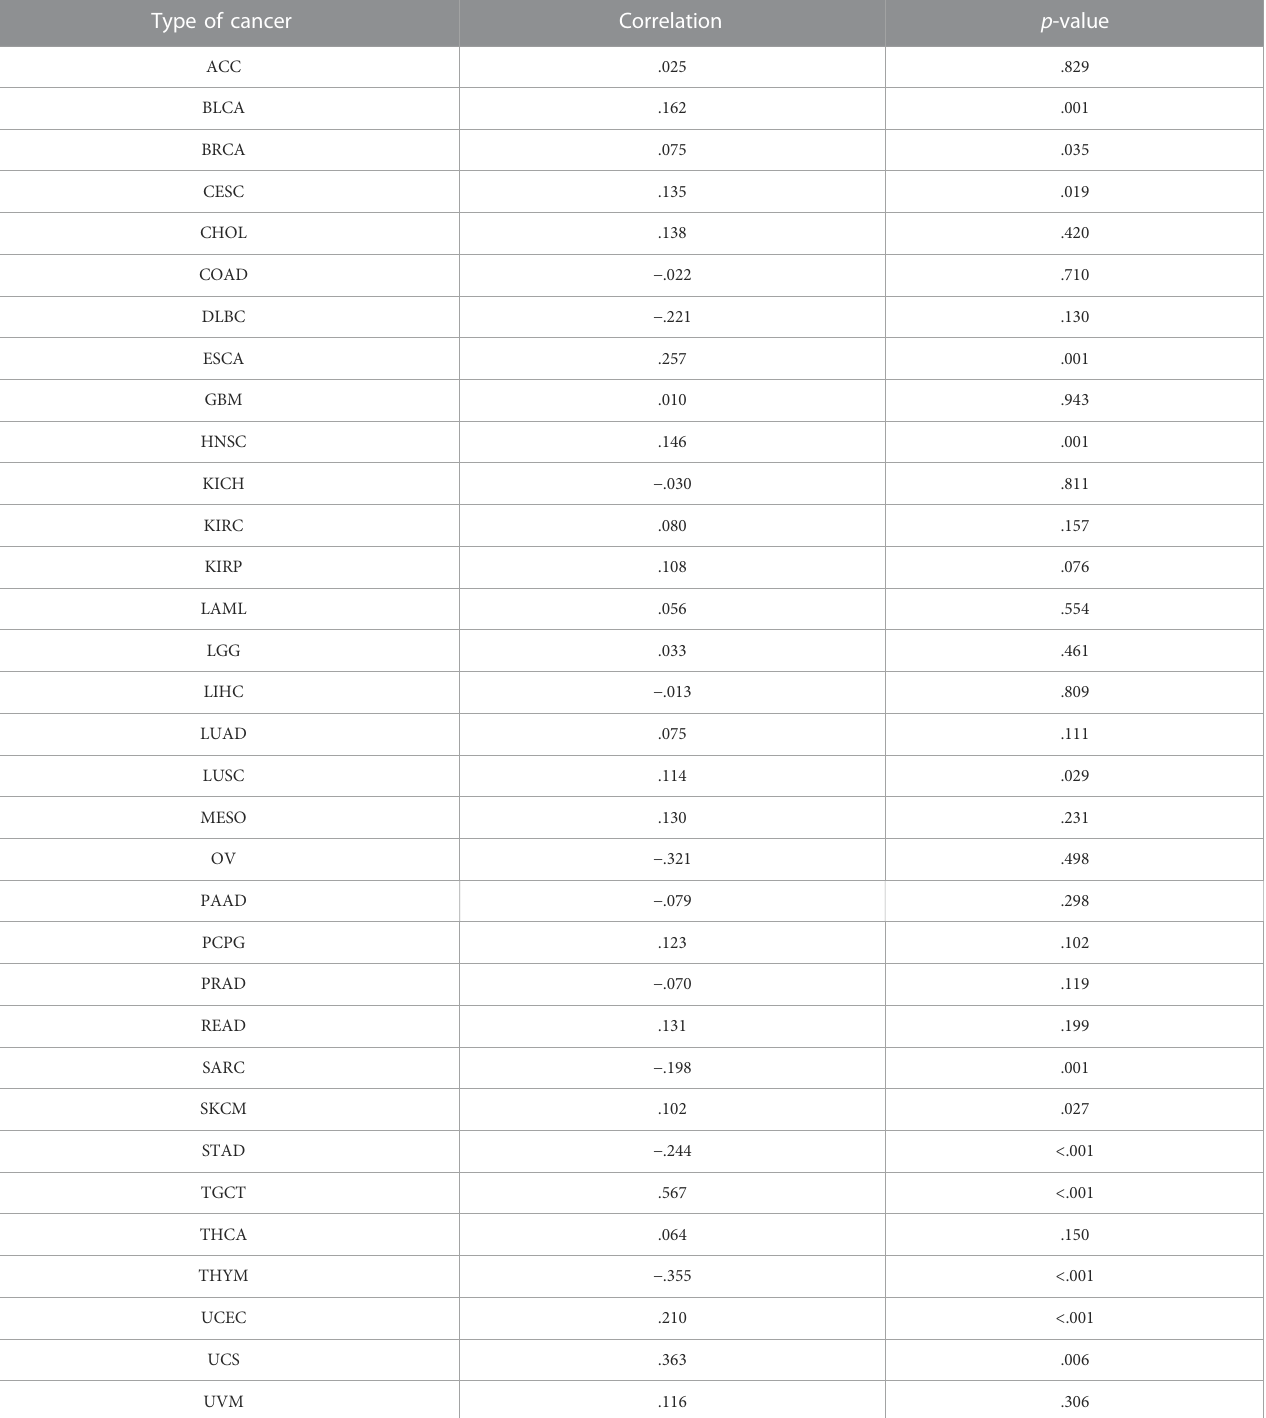
TABLE 1 Relationship between ANXA2 expression and DNA methylation in pan-cancer. Type of